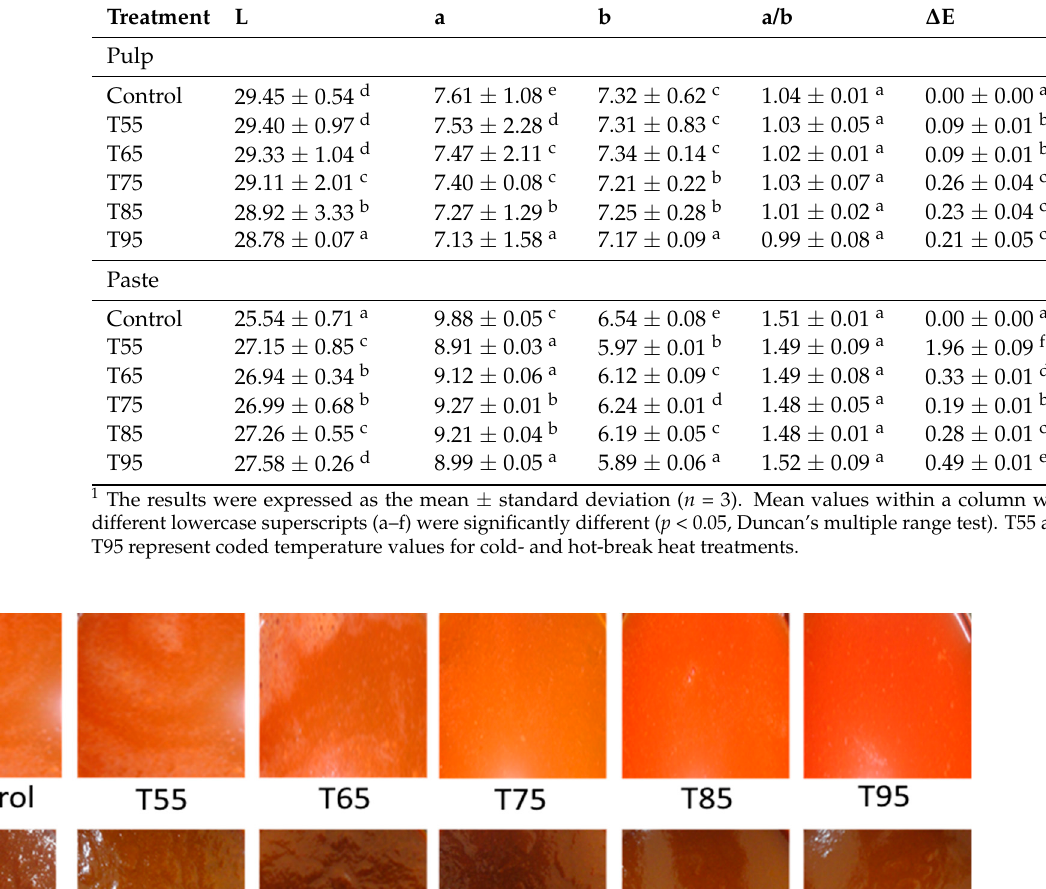
ments. 3.2.2. Apparent Viscosity, Lycopene Content, Total Soluble Solids, and Total Titratable Acidity Figure 4 shows the apparent viscosity, lycopene content, total soluble solids, and total titratable acidity of tomato pulp as a function of heat treatments. The apparent viscosity of tomato pulp differed significantly ( p < 0.05) among the heat treatments and followed no definite trend. However, T85 and T95 showed a decreased apparent viscosity (average of 0.03 Pa.s) compared to control (0.05 Pa.s), indicating the effect of heat treatments on currant tomato pulp. The variations in apparent viscosity could be associated with the alignment of the heterogeneous suspended particles that contributed to a strong particle aggregation [18]. Another study by Augusto et al. [26] explained the contribution of par- ticle size in tomato pulp and suggested the homogenization of tomato products to